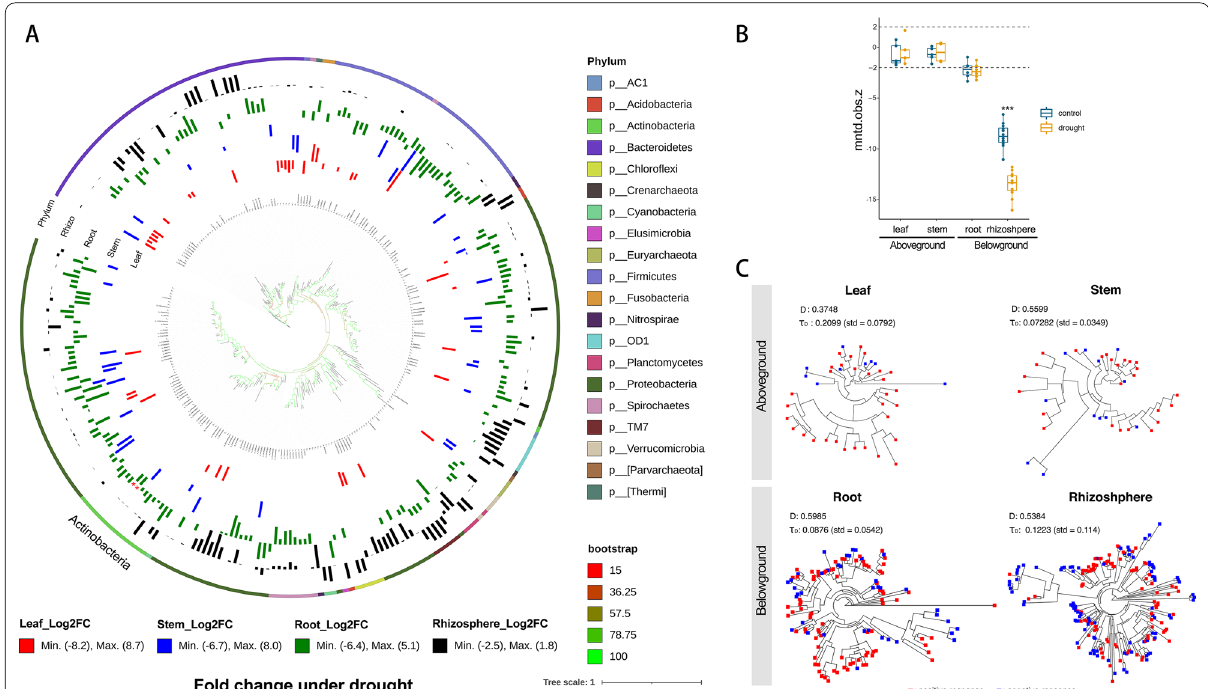
Fig. 3 Phylogenetic distribution patterns. A Phylogenetic tree of all drought-enriched and -depleted ASVs. The phylogenetic tree at the center of the figure was constructed from one representative ASV sequence from all ASVs with 1.2-log 2 fold changes (|log 2 FC|> 1.2) in leaves, stems, roots, and rhizosphere of Oryza longistaminata . The outer ring colored ring represents the phylum each ASVs belongs to. The middle ring of colored bars represents the relative log 2 -fold enrichment (out) or depletion (in) of each ASVs within drought-treated compartments compared with control compartments. B Variation in the standardized effect sizes of the MNTD (SES MNTD ) of microbial communities between drought and control conditions. Horizontal dashed lines indicate the upper ( 2) and lower ( 2) significance thresholds. C Phylogenetic signal showing the level of trait + − conservatism under drought. D: Fritz and Purvis index. τ D : genetic